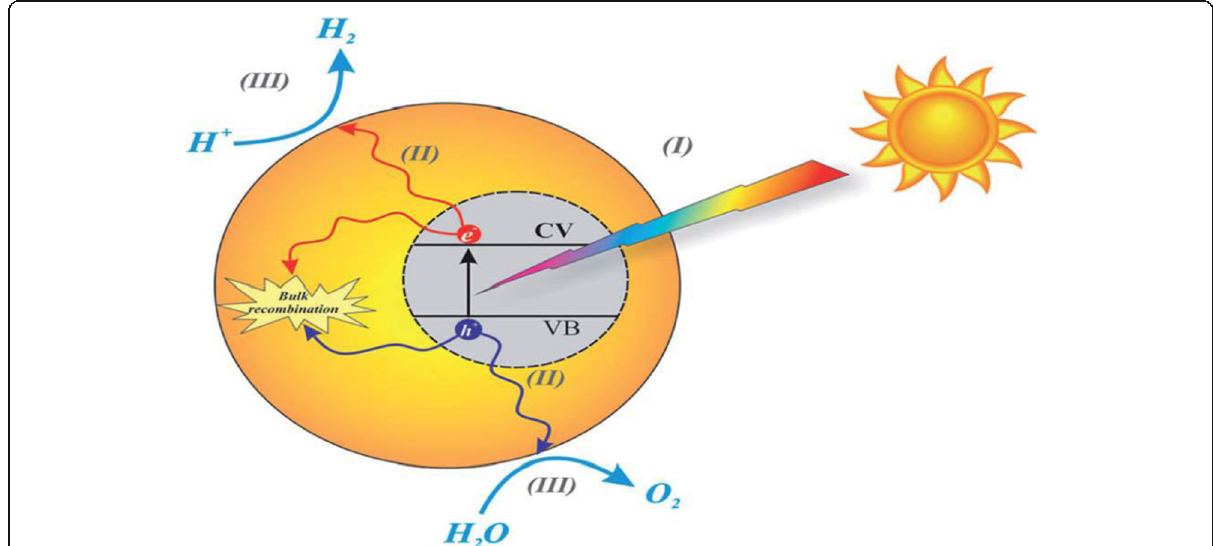
Fig. 1 Schematic diagram of the basic mechanisms of the photocatalytic activity of water splitting. Reproduced with permission [113, 114]. Copyright 2015 & 2018. The Royal Society of Chemistry